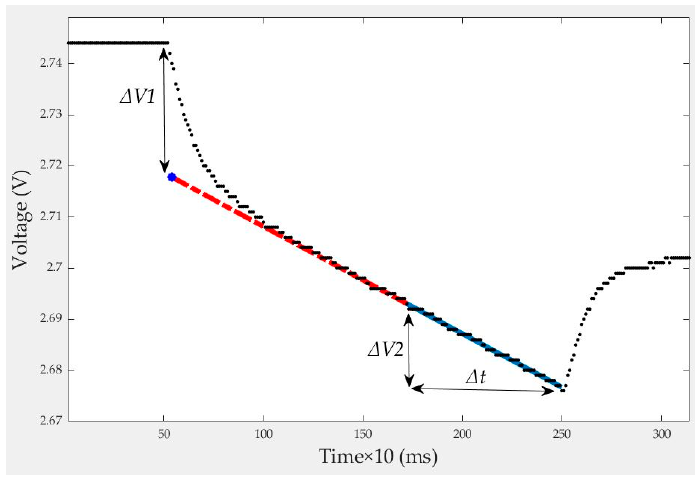
Figure 2. Voltage measured as a function of time in order to calculate internal resistance and capacitance.